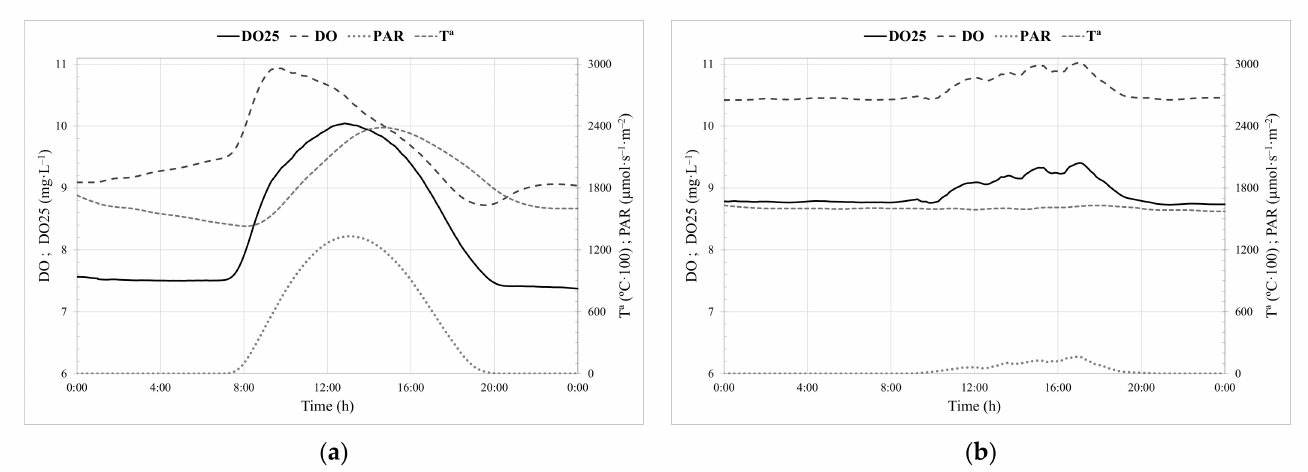
Figure 2. Daily evolution of dissolved oxygen (DO) concentration, dissolved oxygen concentration, standardised at 25 ◦ C (DO25), and PAR during: ( a ) a sunny day (operating day 12); and ( b ) a cloudy day (operating day 17).